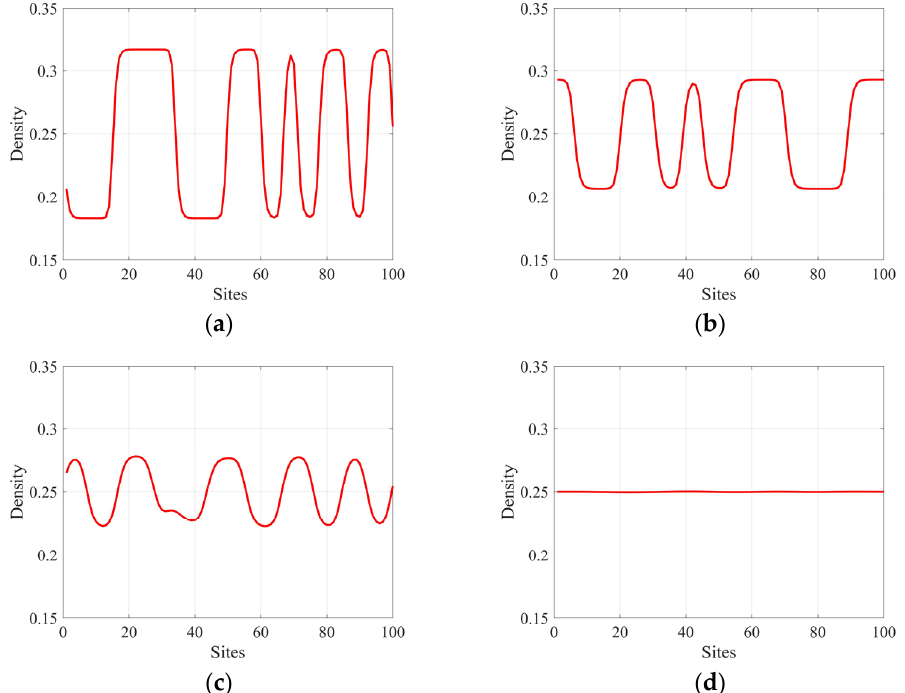
= Figure 5. The flux profile at 3000 t s under the different value of k . ( a ) 0 k = , ( b ) 0.1 k = , ( c ) Figure 5. The flux profile at t = 3000 s under the different value of k . ( a ) k = 0, ( b ) k = 0.1, ( c ) k = 0.15, . ( d ) k =